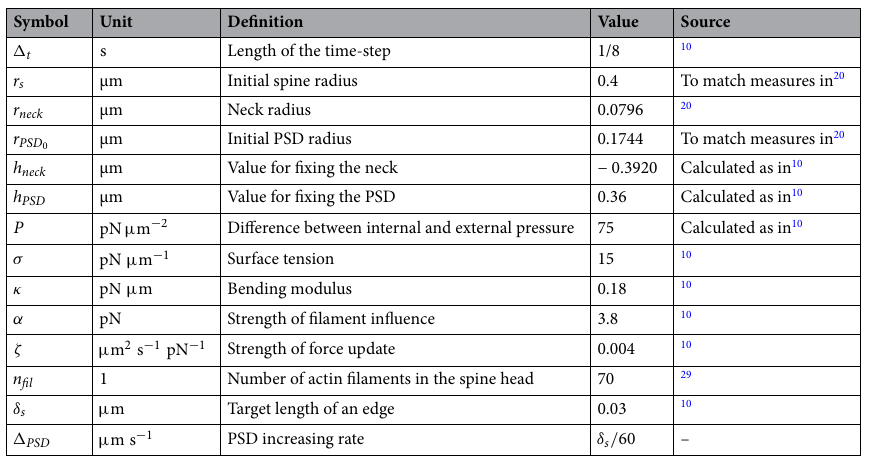
Table 1. Model parameter